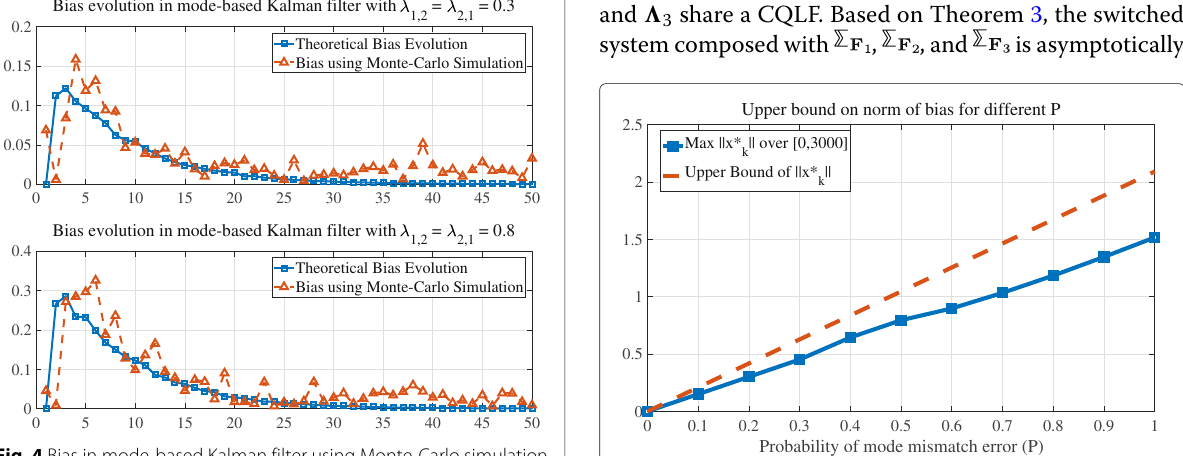
Fig. 4 Bias in mode-based Kalman filter using Monte-Carlo simulation and theoretical bias evolution for switching signal